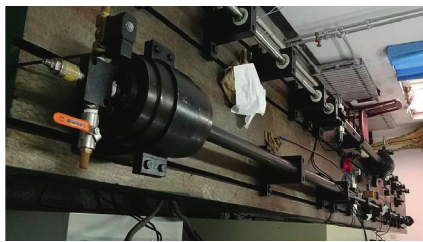
Figure 7: Hopkinson bar impact test